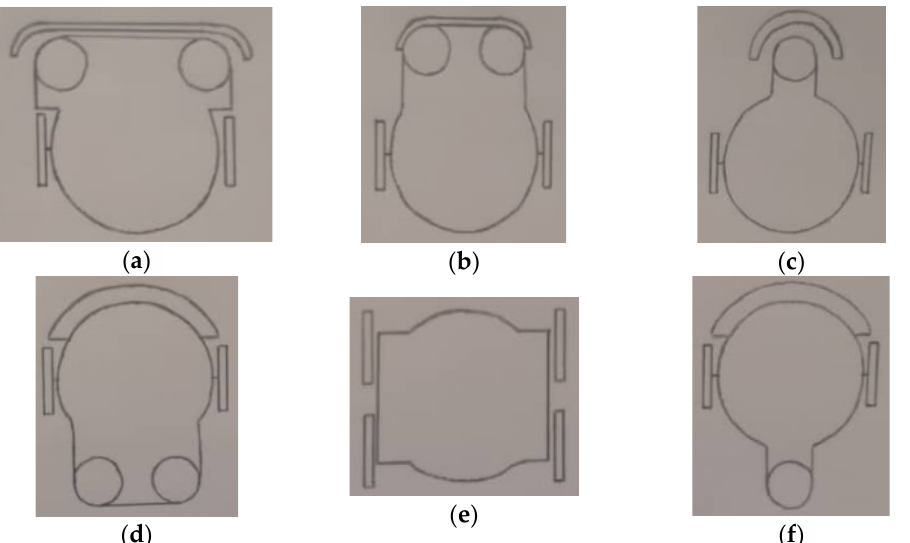
Figure 1. Possible configurations of a smart lawnmower. ( a ) Two-wheel drive with caster wheels at the front. ( b ) Idler wheels mounted before drive wheels and cutting area. ( c ) One wheel instead of two, and the wheel at the front. ( d ) Wheels at the rear. ( e ) Four wheels and no caster wheels. ( f ) Trailing wheel is at the rear.